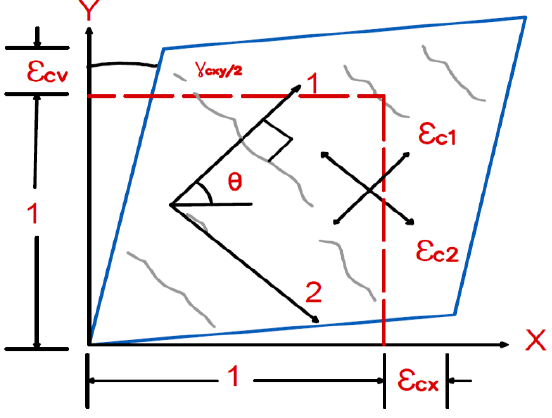
Figure 1. Average Concrete Strains [12,29].